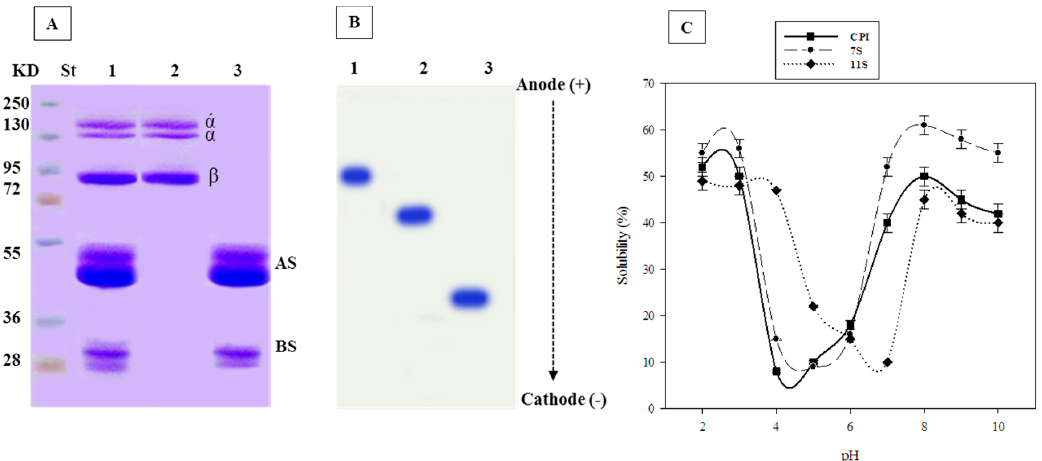
Figure 1. Biochemical characters of cowpea proteins . ( A ) SDS-PAGE; where St = Standard protein, Lane 1: cowpea native protein (CNP), Lane 2: 7S globulin, Lane 3: 11S globulin, AS: Acidic subunit, BS: basic subunit. ( B ) UREA-PAGE and ( C ) pH solubility of CNP.